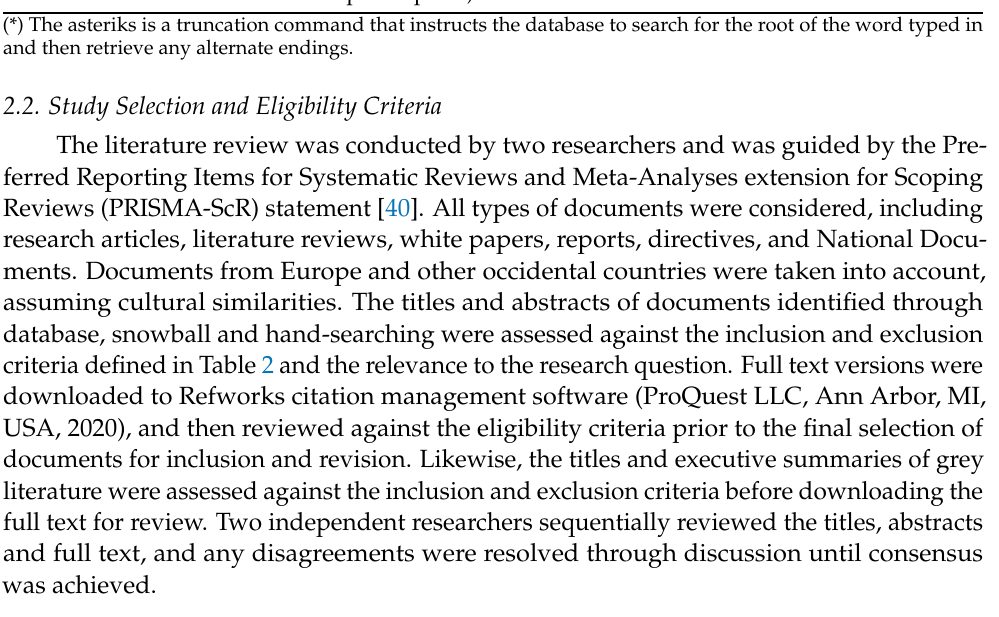
Table 2. Inclusion and exclusion